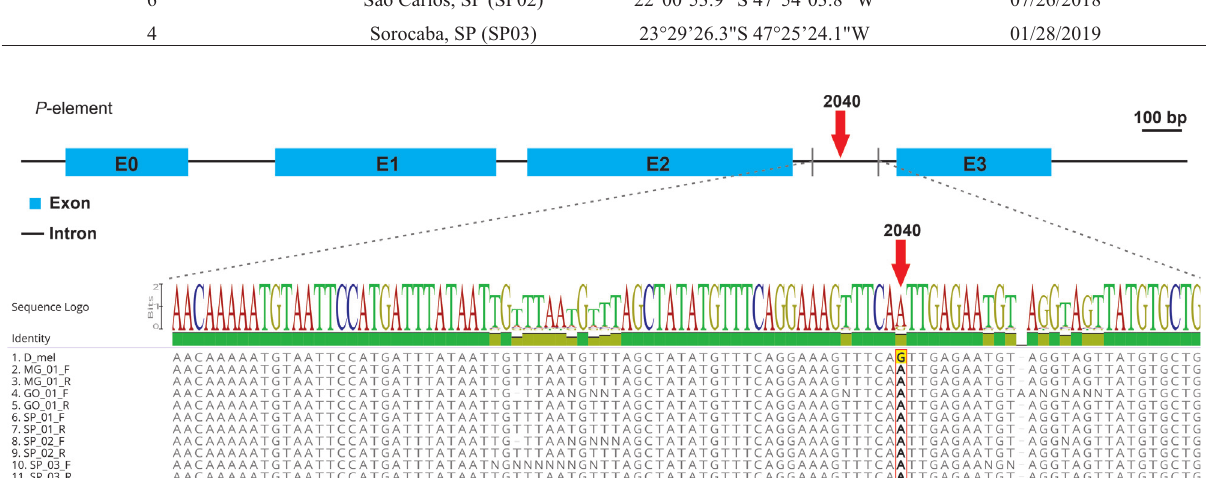
Figure 2 - Schematic representation of a full P -element sequence (above). Nucleotide alignment containing partial intron 3 sequences from the five D. simulans sampled populations together with the reference sequence (Flybase ID: FBte0000037) from D. melanogaster (D_mel) (below). Position 2040 (highlighted) has the nucleotide A in all D. simulans sequences, which is a marker of this species’ P -element. DNA sequencing was performed with For- ward (F) and Reverse (R) primers directly from non-cloned PCR products. `N’ denotes nucleotide positions with low sequencing quality in the